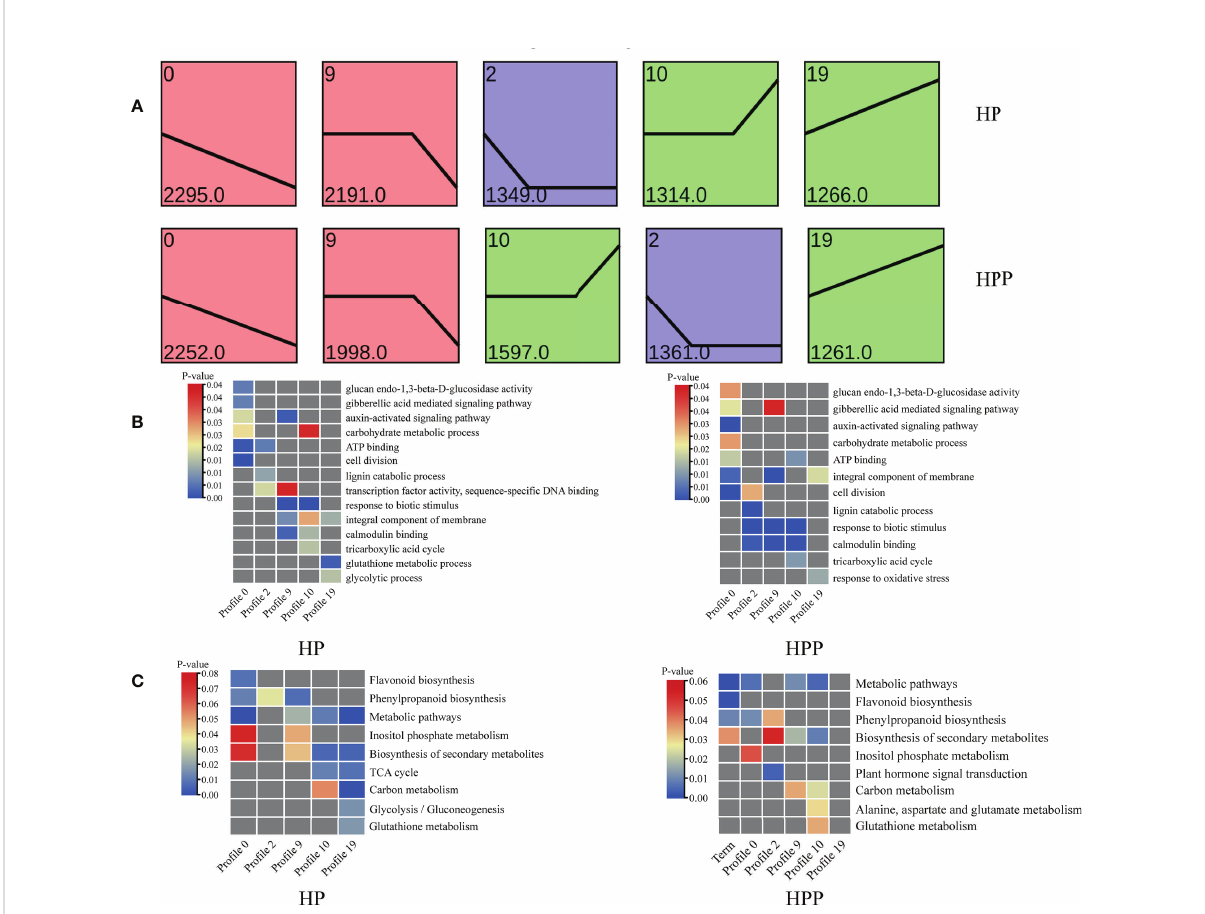
FIGURE 7 Gene-expression patterns and enrichment of Gene Ontology (GO) terms and Kyoto Encyclopedia of Genes and Genomes (KEGG) pathways at four different time-points in Harumi/Hongjv (HP) and Harumi/Ponkan/Hongjv (HPP) fruits. (A) Gene-expression patterns at three time-points in HP and HPP fruits, as predicted using STEM software. The number of genes and P -values for each pattern are indicated in each frame. (B) GO enrichment analysis of important processes in HP and HPP fruits. (C) KEGG pathway enrichment analysis of important processes in HP and HPP fruits. P -values indicate the signi fi cance of the most enriched GO and KEGG Slim terms. Signi fi cant and non-signi fi cant P -values are indicated in red and dark gray,